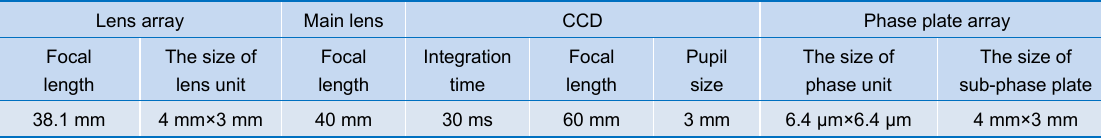
Table 1 | The experimental setup parameters of LA, main lens, camera and